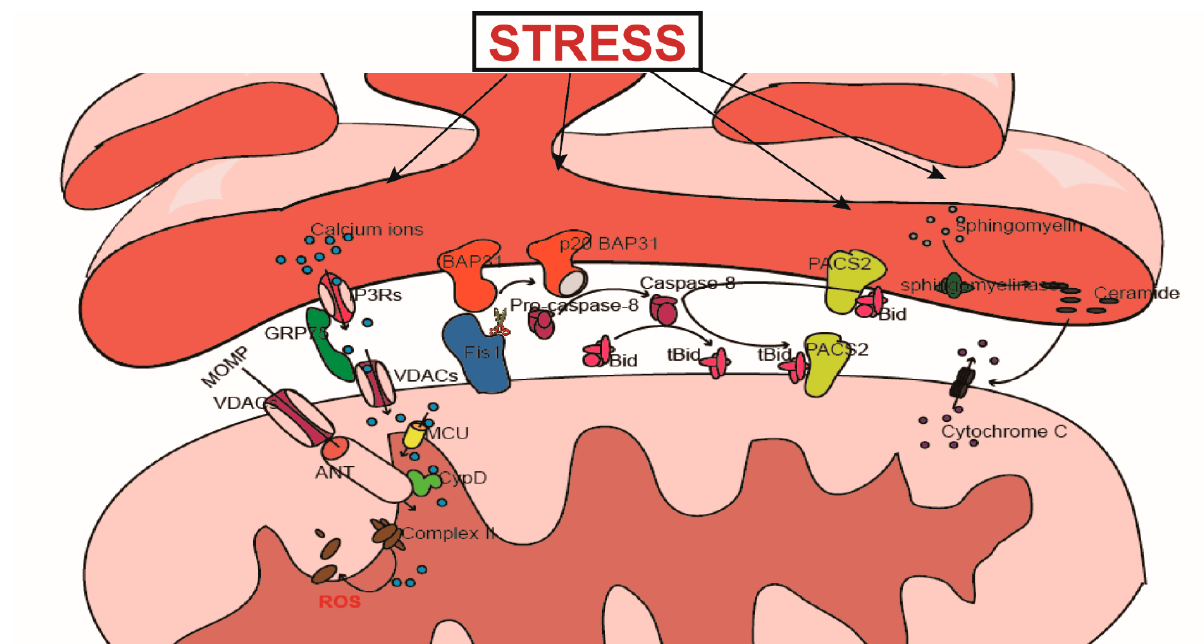
Figure 2. Under stress conditions, endoplasmic reticulum (ER) can act as a sensor and respond immediately. Meanwhile, if the stress intensity exceeds the adaptability of the ER, it will transmit death signals to mitochondria to initiate death events. The transduction can go through some pathways as follows: 1.ER perfuse Ca 2+ into mitochondria and massive Ca 2+ in mitochondria works as a death signal initiating cell death; 2. translocation of PACS1 from ER to mitochondria, which is along with the activation and translocation bid; 3. ceramide synthesis and accumulation causing the mitochondrial outer membrane permeabilization (MOMP), which results in the release of cytochrome c or other pro-apoptotic substances in inter membranes space. Also, as a molecule downstream of mitochondrial apoptosis, Fis1 can transmit apoptosis signal back to ER by cleaving BAP31. The ER-mitochondria-ER amplification loop of apoptotic signals can help to coordinate the death events between the two organelles.